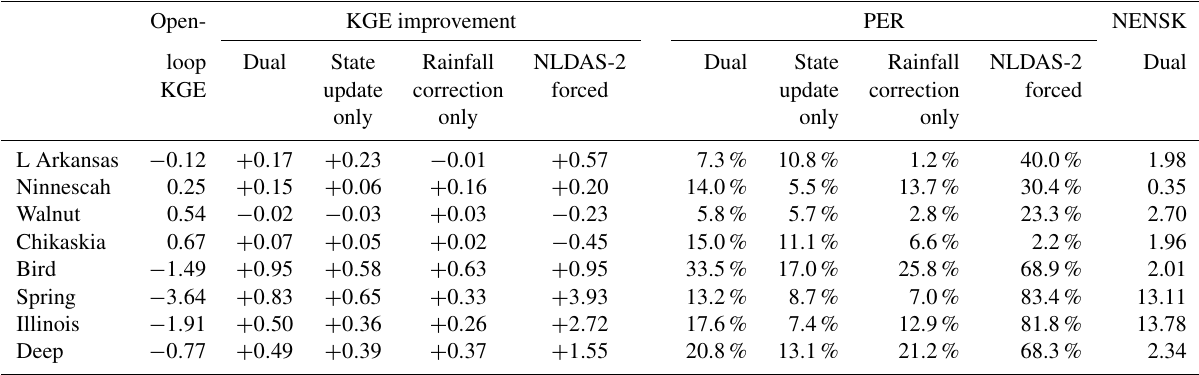
Figure 5. Maps of SMART rainfall correction results (with λ = 0 . 1, EnKS, and rainfall corrected only during time steps with nonzero rainfall). Each column shows the following metrics, respectively: percent RMSE reduction (PER) (a–c) and ensemble NENSK (d–f) . Each row shows results based on different temporal accumulation period: every 3h and every 1 and 3d, respectively. The number in the lower left corner of each subplot shows the domain-median statistic. Table 2. Daily streamflow results from the dual-correction system for the eight USGS sub-basins shown in Fig. 1. In addition to the deter- ministic KGE improvement, PER, and probabilistic NENSK results from the dual system (“dual” columns), the table also lists the open-loop streamflow KGE (“open-loop KGE” column), KGE improvement, and PER as a result of state update or rainfall correction scheme alone (“state update only” and “rainfall correction only” columns, respectively), and KGE improvement and PER when forced by the NLDAS-2 benchmark precipitation without state update (“NLDAS-2 forced”